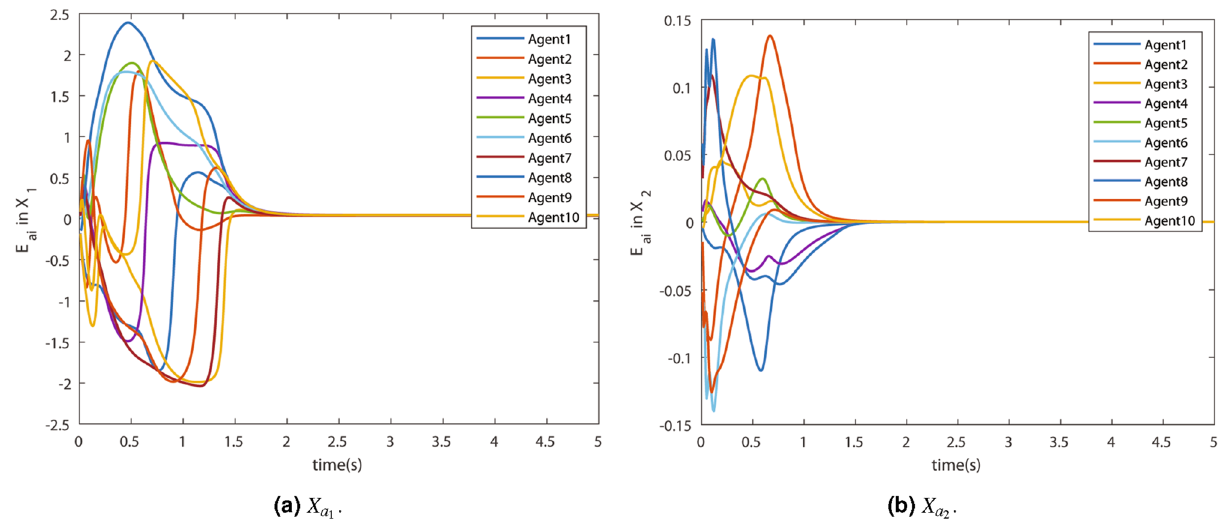
Figure 9. Virtual error E ai